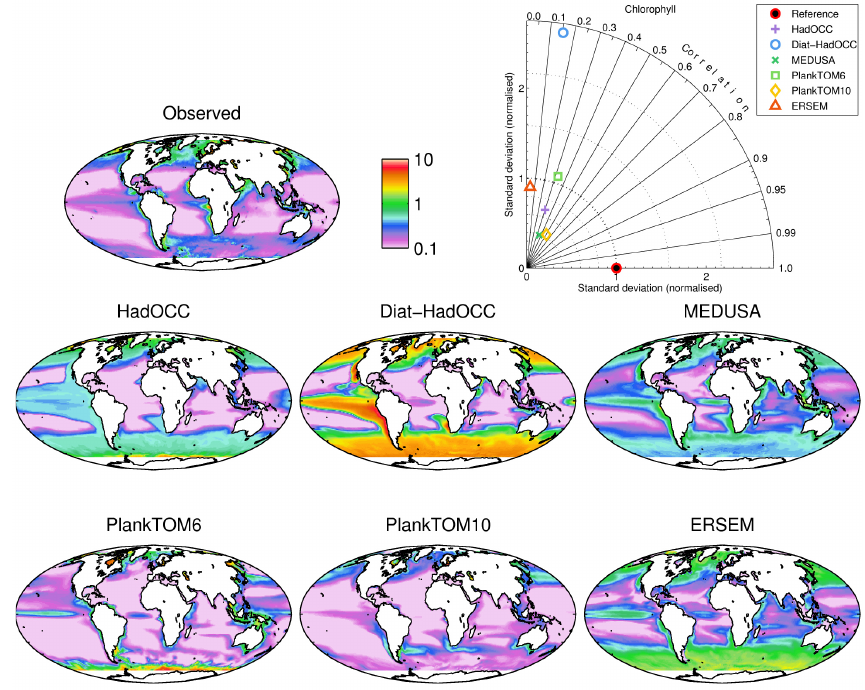
Figure 3. Observational (SeaWiFS; top left) and modelled annual average surface ocean chlorophyll (mgm − 3 ) for the period 2000–2004. To avoid biasing the plots, observational data and model output are only shown for regions in which all months were represented at least once across all of the sampled years. Mean field values: observations 0.215; HadOCC 0.347; Diat-HadOCC 1.170; MEDUSA 0.346; PlankTOM6 0.312; PlankTOM10 0.160; ERSEM